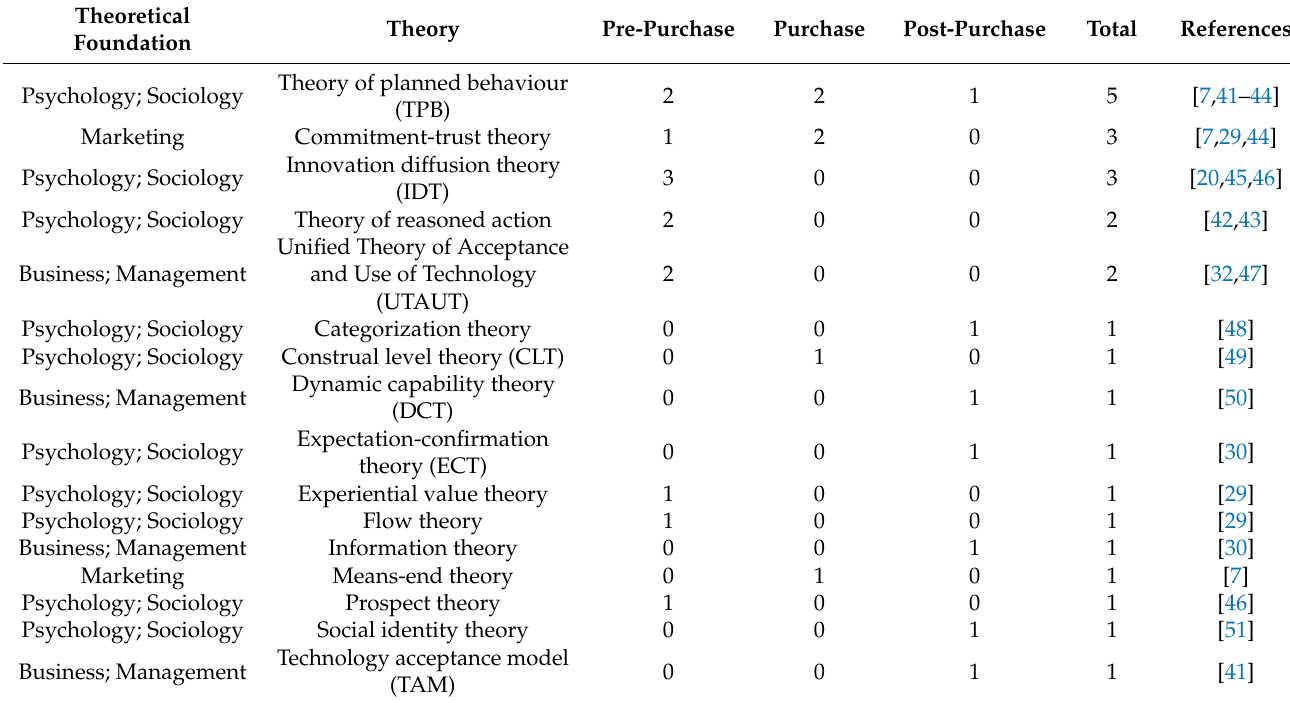
Table 2. Major theoretical